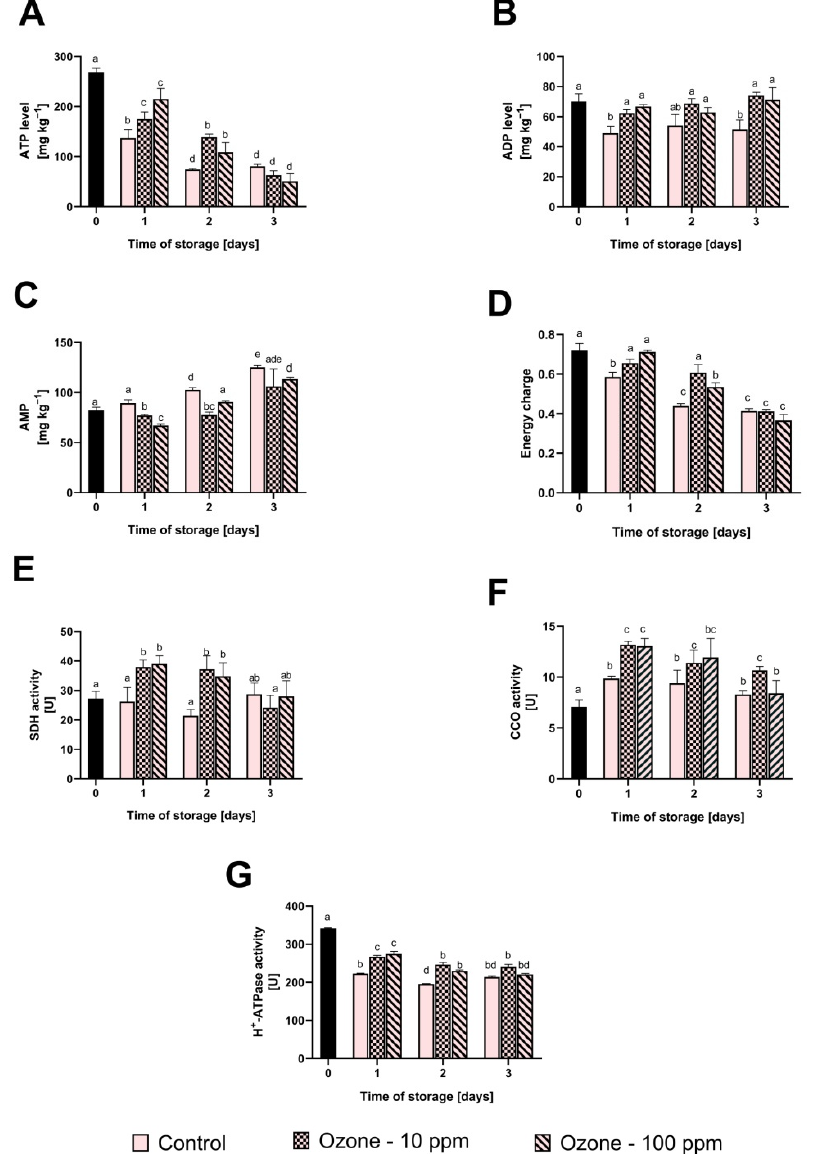
Figure 3. Influence of ozone treatment on the level of ATP ( A ), ADP ( B ), AMP ( C ), energy charge ( D ) and the activity of succinate dehydrogenase ( E ), cytochrome C oxidase ( F ) and H+ATPase ( G ) in strawberry fruit during storage at room temperature. Mean values with standard deviations (error bars), with the same lower case are not statistically significant according to the t-Tukey test ( α = 0.05).